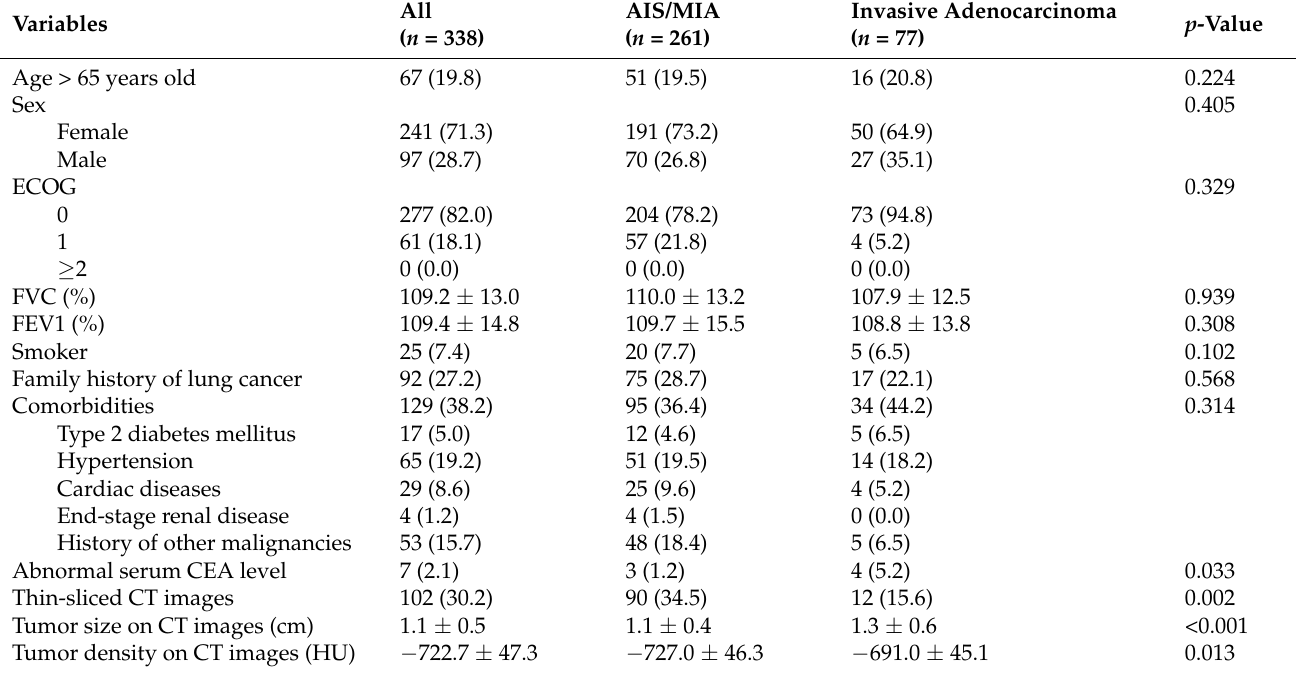
Table 1. Demographic and clinical